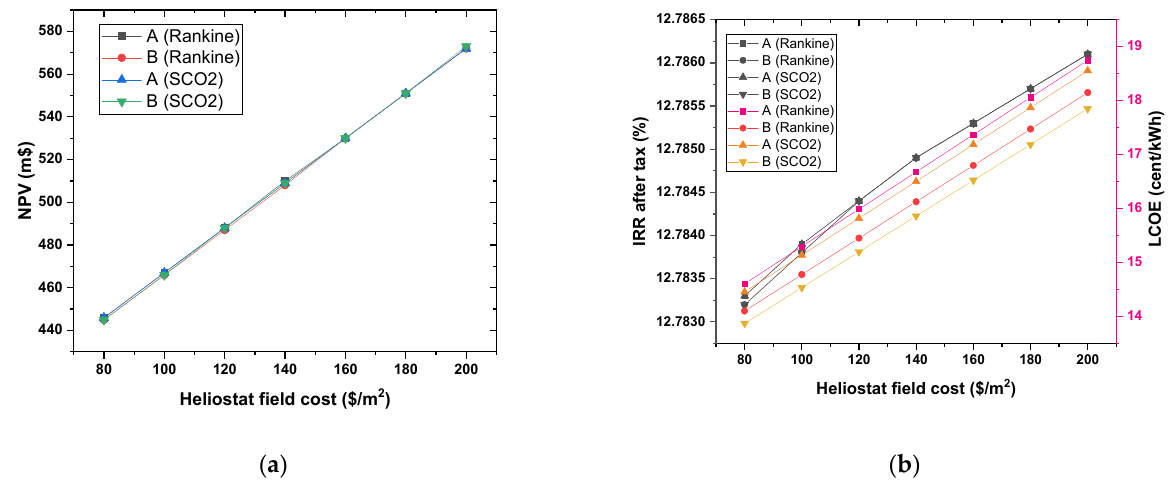
Figure 10. Effect of real discount rate on NPV (in million dollars) and LCOE of the various scenar- ios.